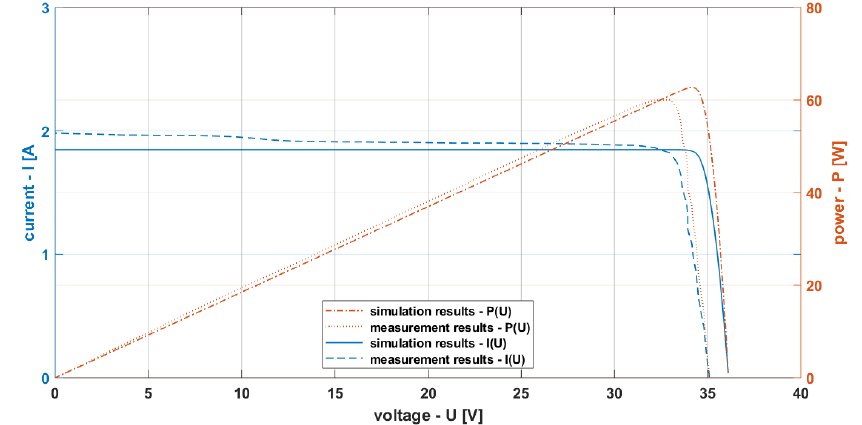
Figure 8. I–V characteristics of PV module STP255-20/Wd made with partial shading. For detailed comparison of measurement and simulation results, see Table 2. Marking of measurement point P3 (six PV cells were shaded; the exact measurement time was 10:49 a.m.).